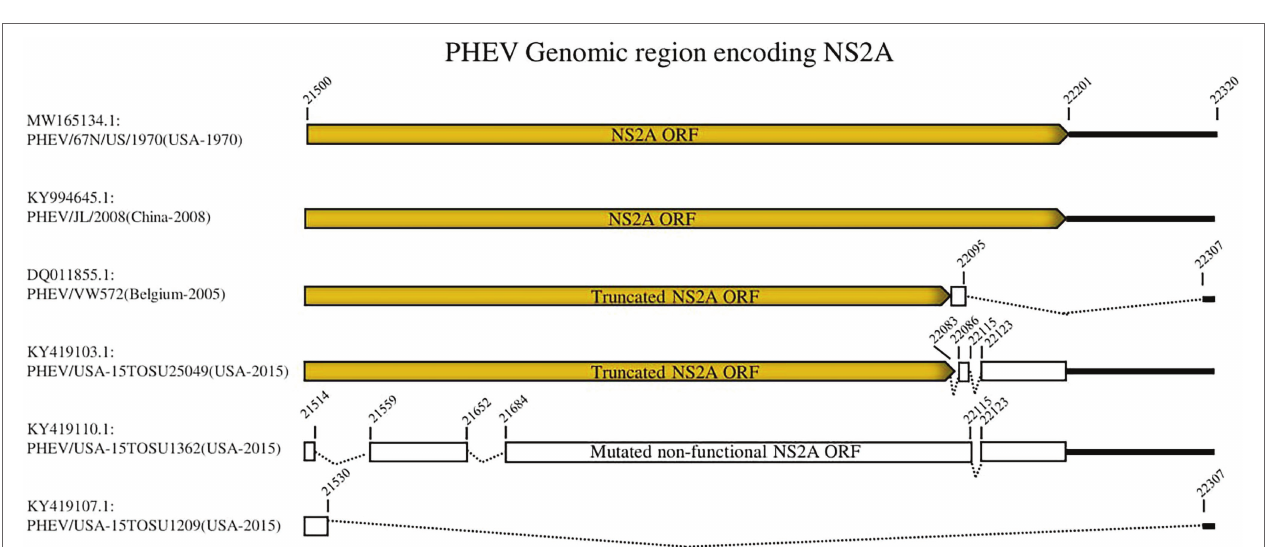
FIGURE 3 | Deletion patterns in NS2A ORF region. The yellow box indicates the expression of full-length or truncated NS2A. The white box indicates the region of non-functional expression. Deleted regions are indicated with dashed lines. The numbers indicate the nucleotide positions relative to the genome of PHEV/67 N/ US/1970 strain (GenBank ID: